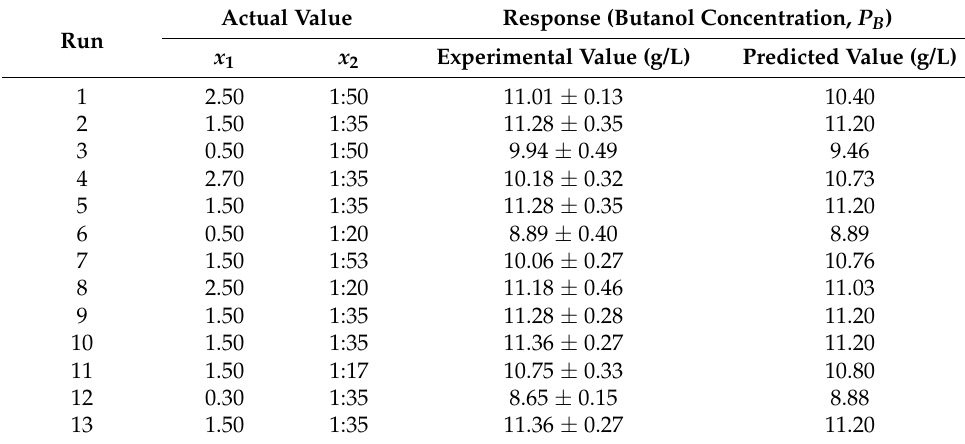
Table 9. Response values (butanol concentration) of 13 experimental runs.